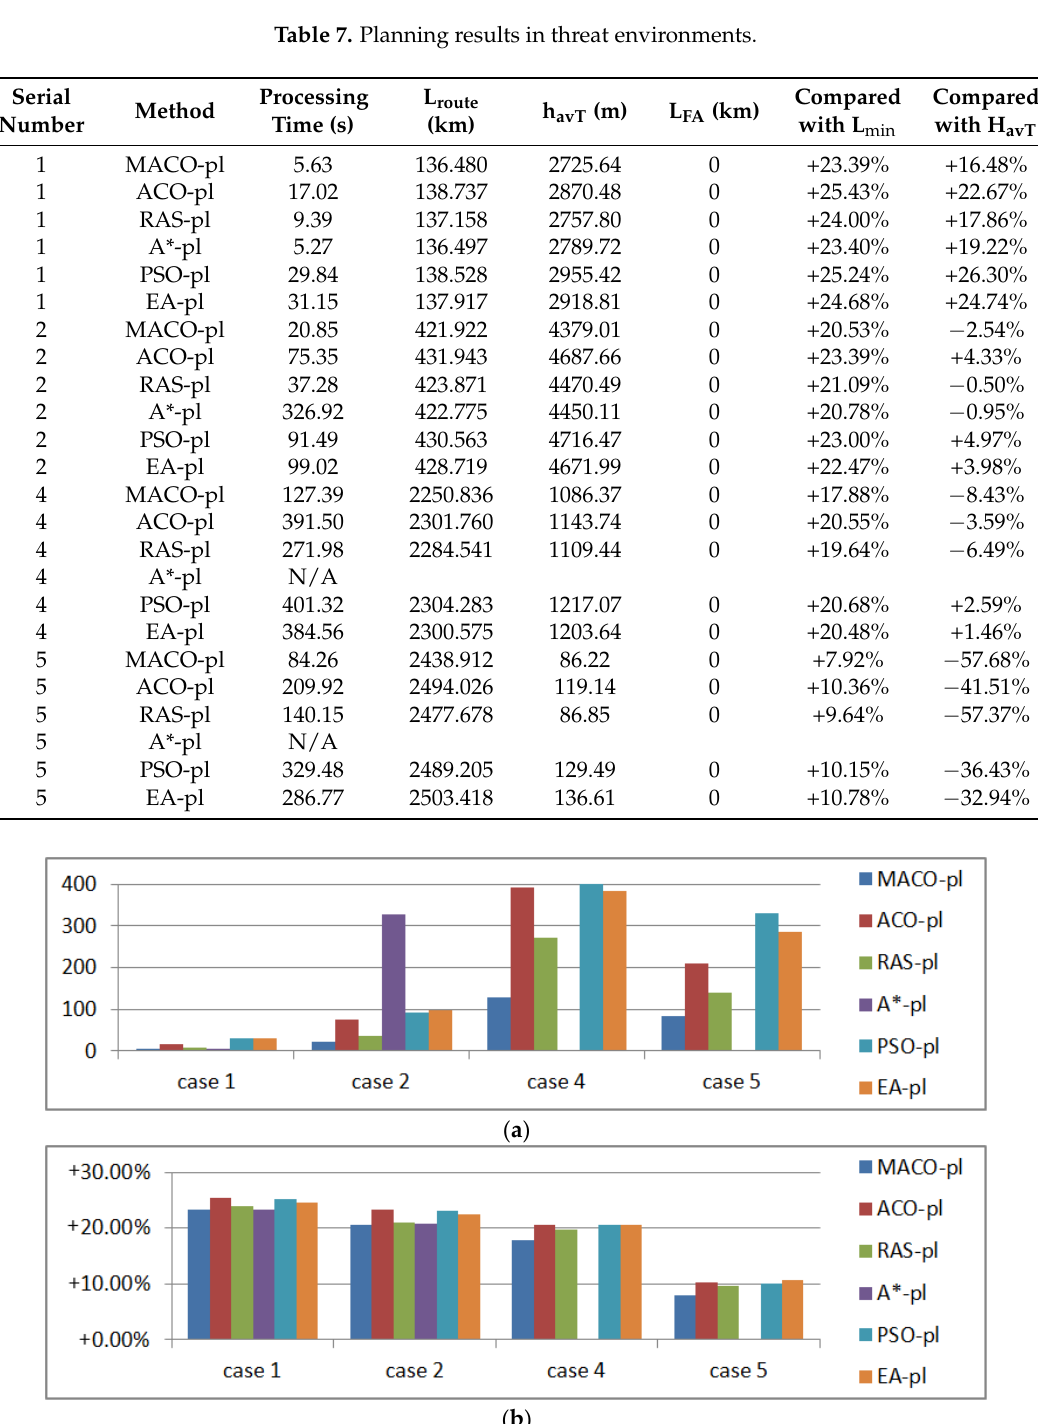
Table 7. Planning results in threat environments.